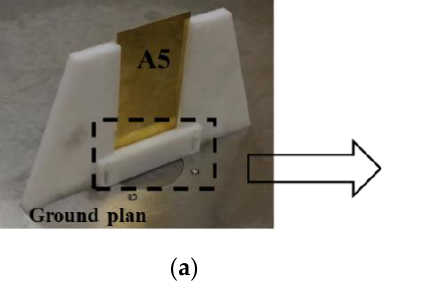
Figure 11. ( a ) planar monopole A5 realized with two P-MDM. ( b ) Slots and two P-MDM.